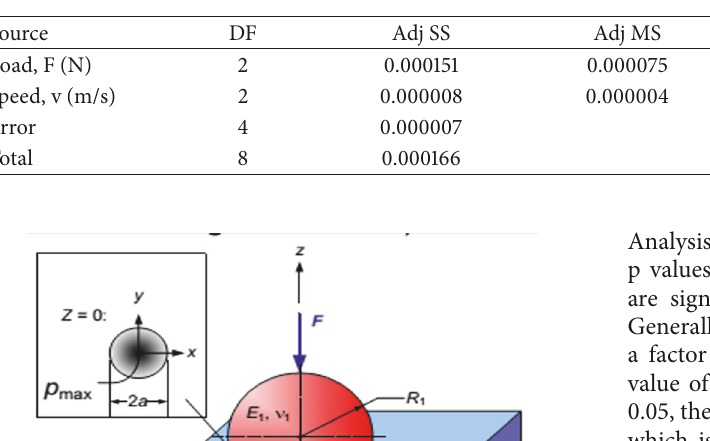
Table 7: ANOVA for volume loss for AISI 304 SS.